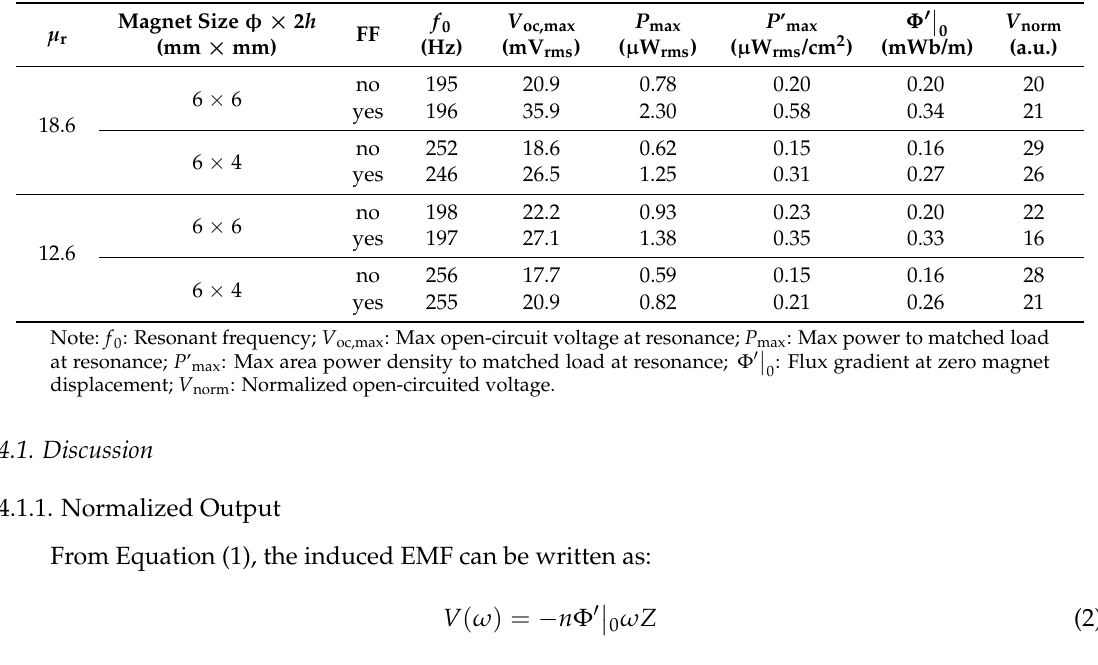
Table 3. Performance summary of the proposed harvester under different test